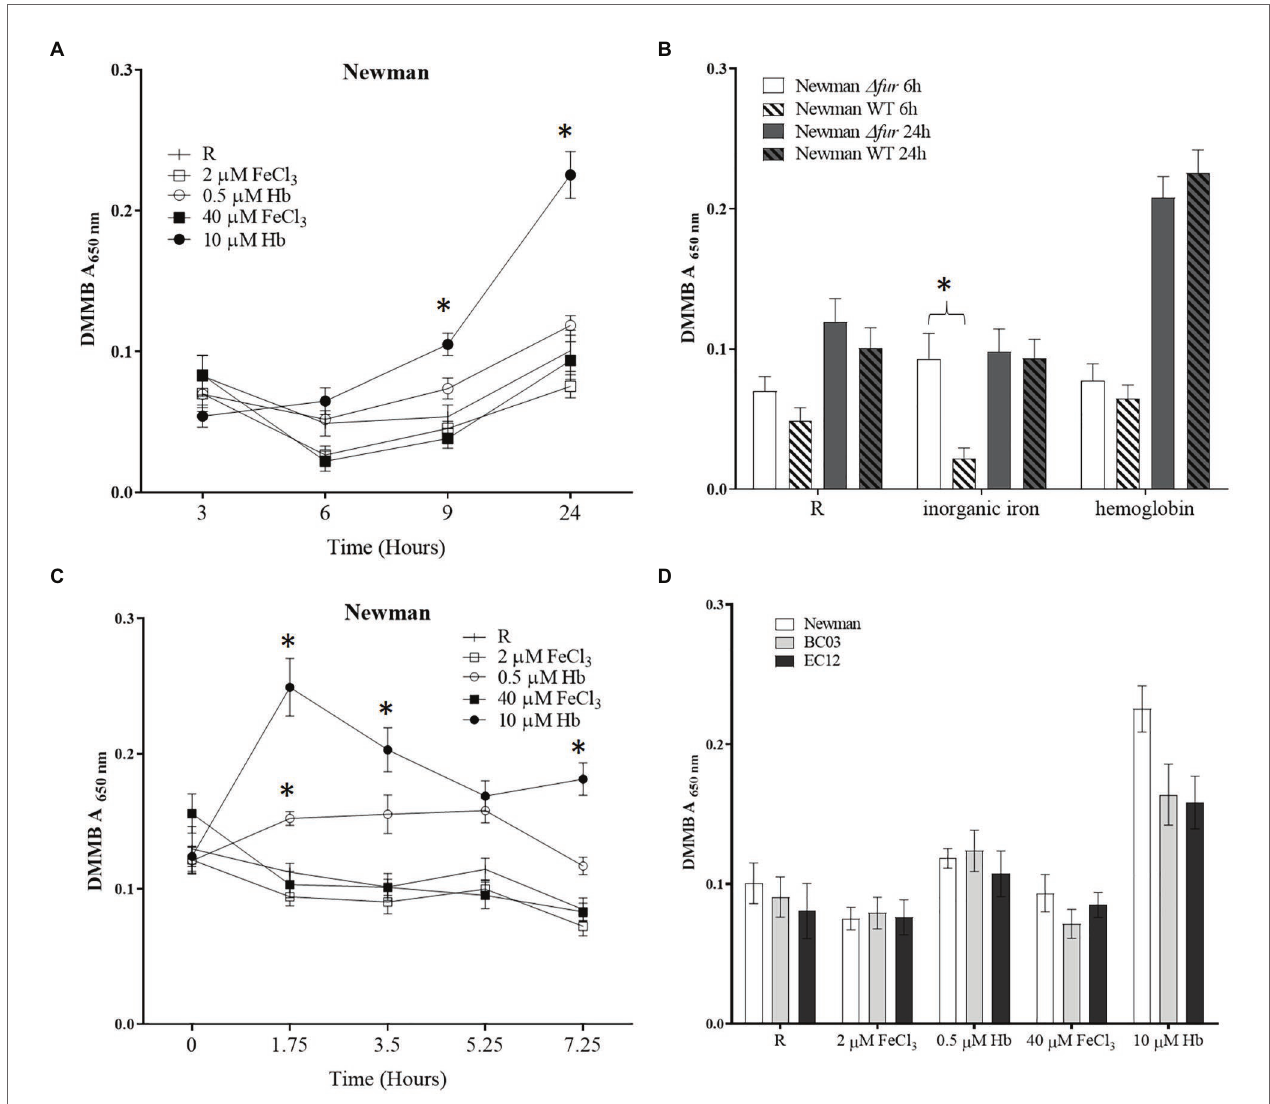
FIGURE 1 | Biofilm matrix quantification with different iron sources. A Staphylococcus aureus culture grown in RPMI overnight resuspended in fresh medium was diluted to a final concentration of 1 × 10 7 CFU ml −1 in 200 μ l of medium [RPMI or RPMI supplemented with 2 and 40 μ M of FeCl 3 or 0.5 and 10 μ M hemoglobin (Hb)] a sterile 96-well microtiter plate. The microplate was incubated at 37 ° C and 200 rpm for desired time. Spent medium was removed and biofilms were washed twice with Phosphate Buffered Saline (PBS). Biofilm matrix was stained with dimethyl methylene blue (DMMB). (A) , biofilm formation through time in Newman WT; (B) , biofilm formation in Newman ∆fur ; (C) , dispersing biofilm through time with addition of iron source in Newman WT; and (D) , biofilm matrix level at 24 h in Newman and two clinical isolates, BC03 (bacteraemia) and EC12 (endocarditis). Data is plotted as mean and error bars represented by SEM. Measurements were taken from quadruplicates wells in a microplate in three independent experiments. Stars denote significant difference ( p < 0.05) tested by one-way ANOVA and Tukey